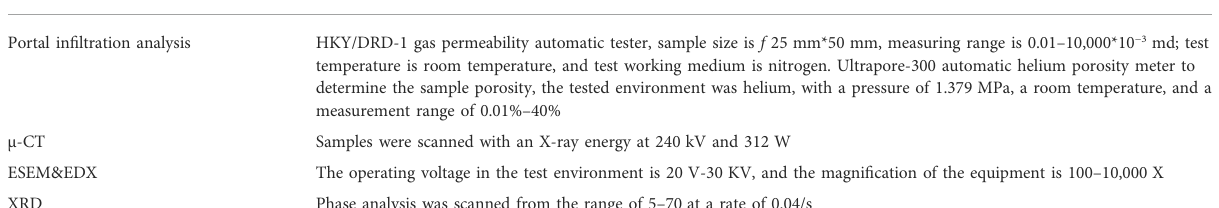
TABLE 3 Measuring parameter.